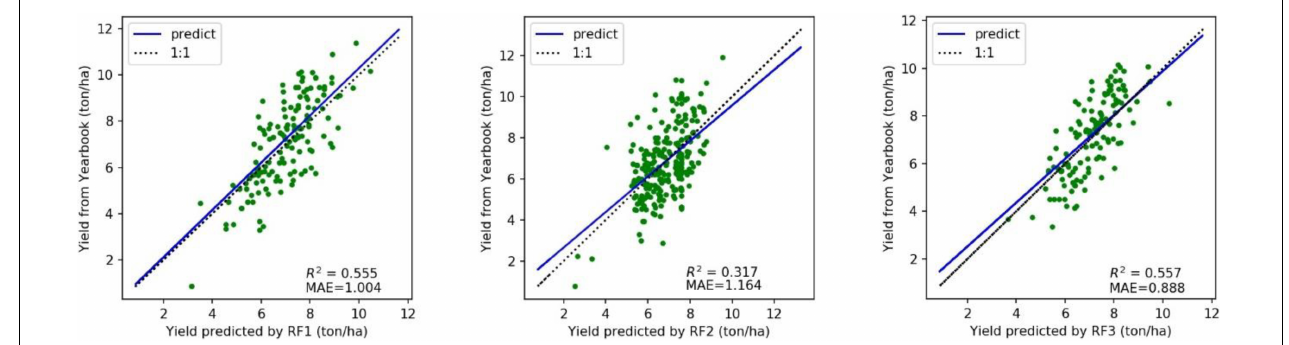
FIGURE 9 | Comparison of accuracy between the three random forest models. (RF1: input FVC_AC; RF2: input FVC_RS; RF1: input